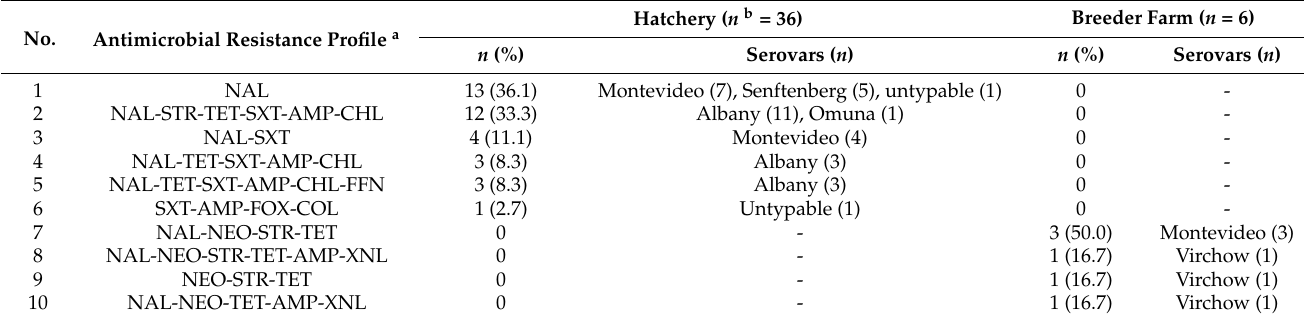
Table 3. Antimicrobial resistance profile of Salmonella isolates from hatcheries and their upstream breeder farm. No. Antimicrobial Resistance Profile a